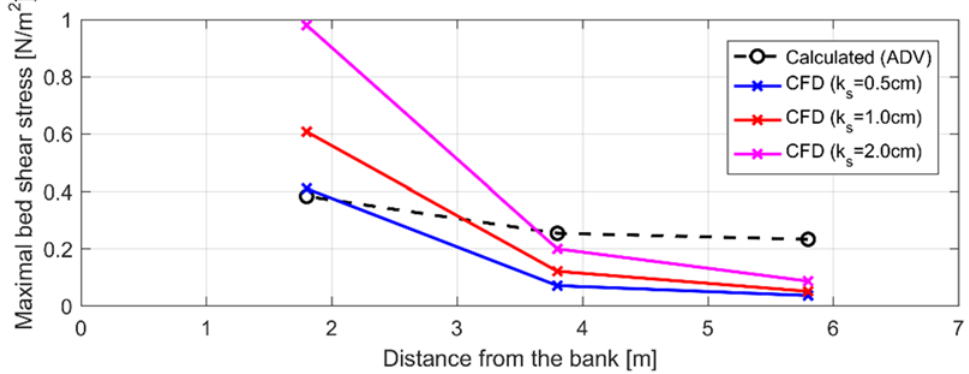
Figure 15. Measured (calculated with Jonsson’s method) and modeled bottom shear stress at different distances from the bank.